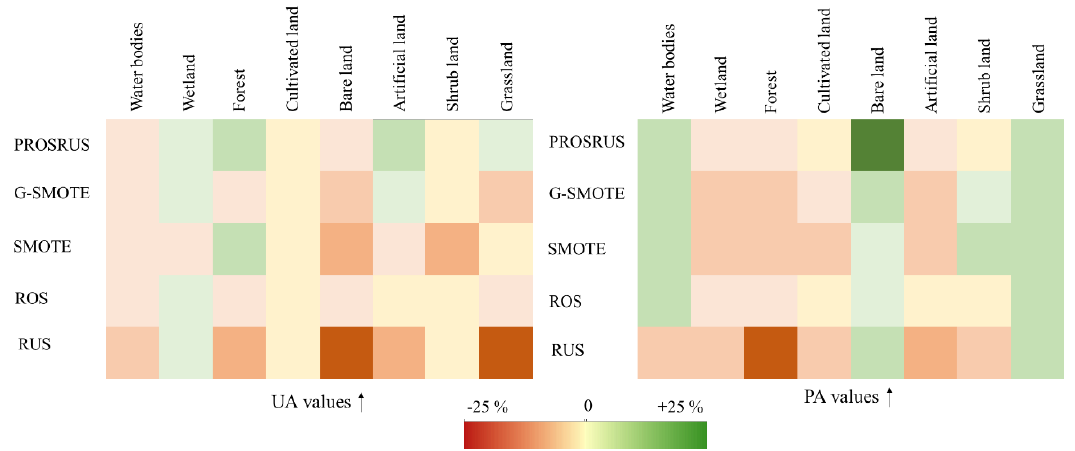
Figure 9. Effects (increase or decrease) of different balancing methods on the UA and PA values of Figure 9. E ff ects (increase or decrease) of di ff erent balancing methods on the UA and PA values of various classes in Site-2. Refer to Appendix D for more information various classes in Site-2. Refer to Appendix D for more